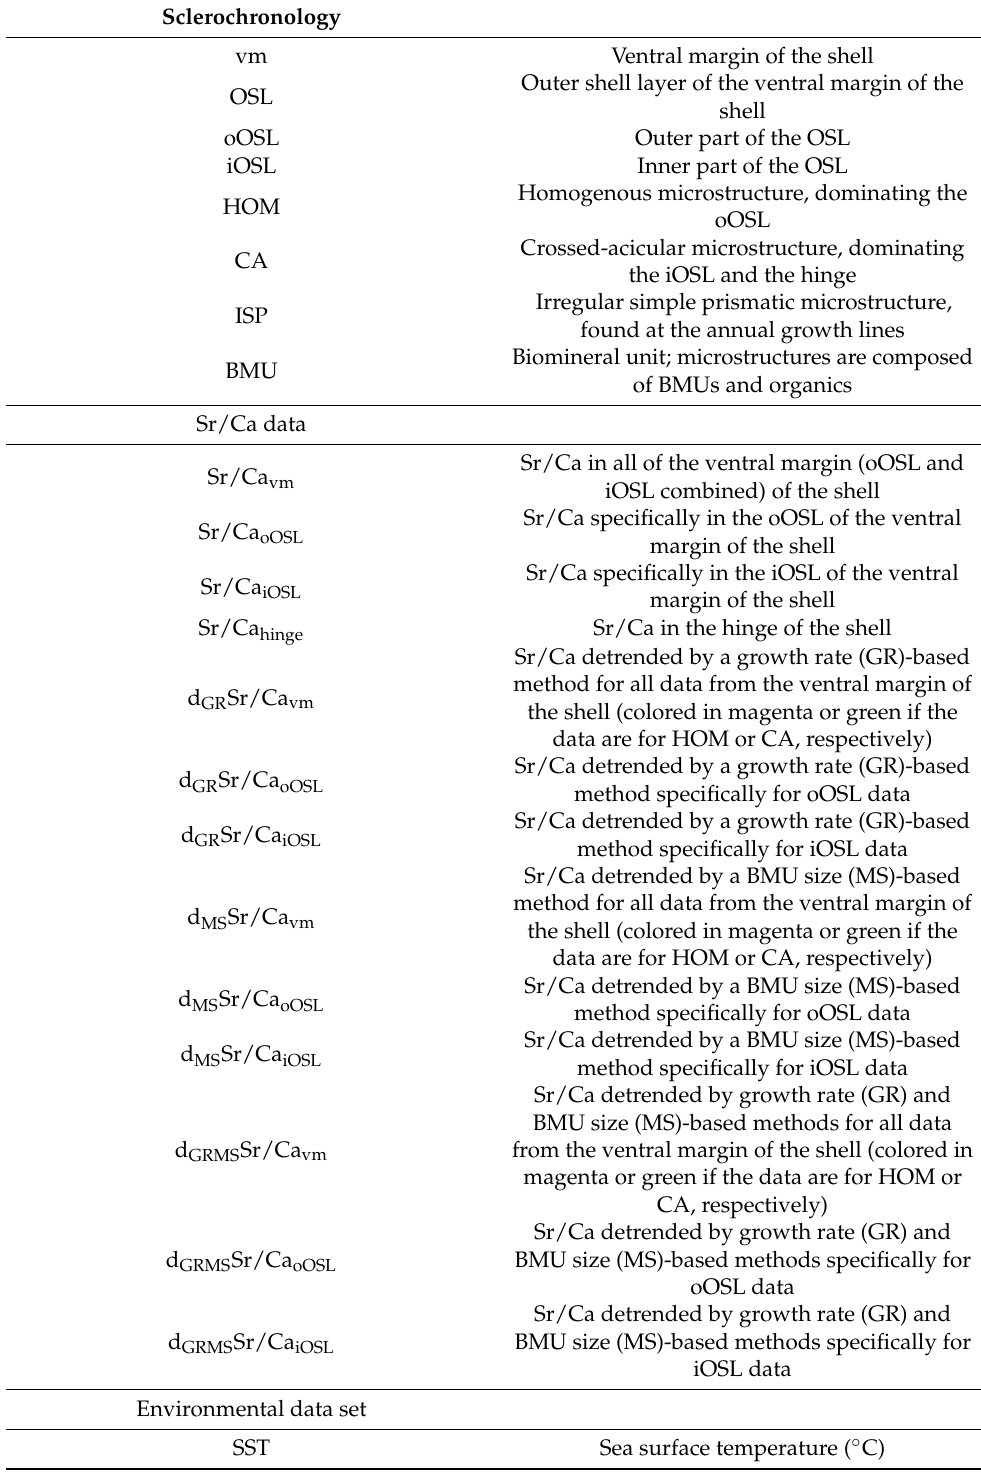
Table A1. Overview of the abbreviations used in the